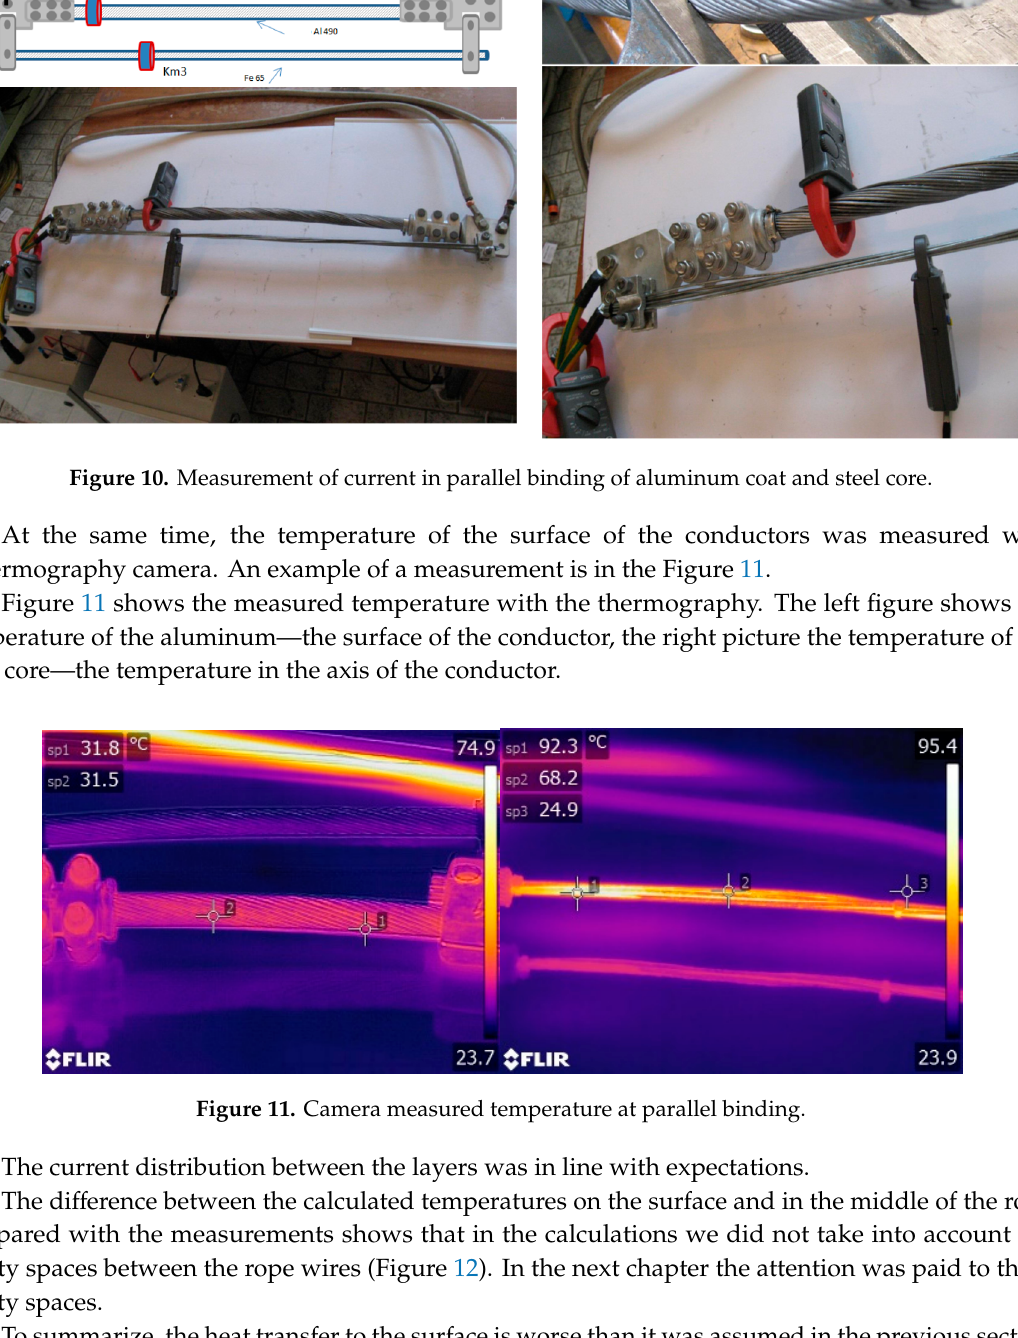
Figure 9. Theoretical current distribution between the steel core and the aluminum coat. Picture of measurement with interrupted aluminum coat.